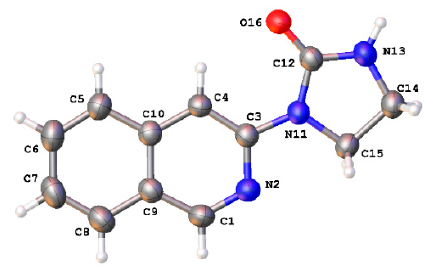
Figure 1. Molecular structure of 3e . Displacement ellipsoids are shown at the 50% probability level.